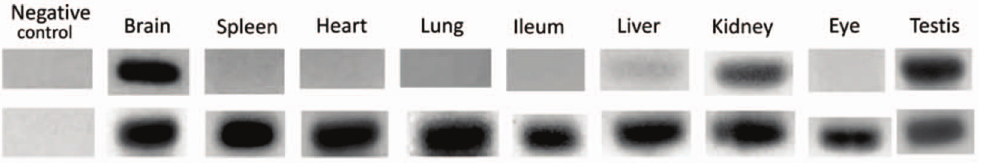
Figure 1. S100B transcription only occurs in barrier organs. Reverse-transcriptase PCR results for S100B ( top row ) and b -actin ( bottom row ) mRNA in various rat tissues. S100B mRNA was found in brain tissue and testis; kidney tubule cells also expressed measurable levels of S100B mRNA. No S100B mRNA was found in organs where S100B protein levels were previously demonstrated by us and others (see [24]). These results summarize outcomes from at least four repetitions. Changing the number of PCR cycles in the protocol from 40 to 35 (see Methods) did not result in any significant changes.